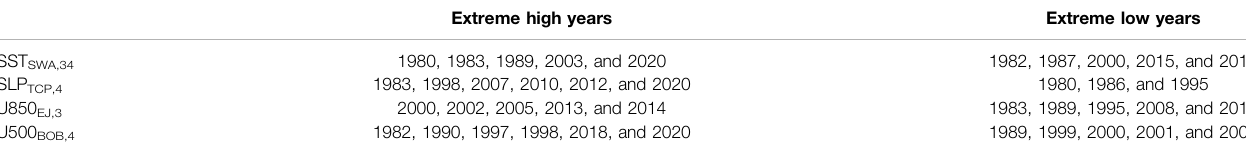
TABLE 3 | Extreme high years ( > 1) and low years ( < − 1) of four predictors based on the respective standardized values of predictors in 1979 – 2020.